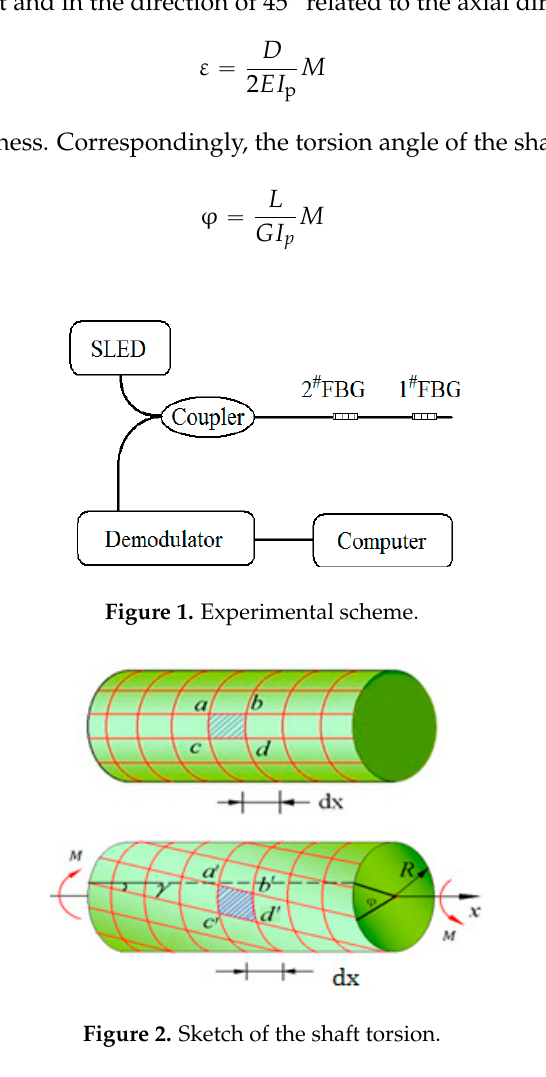
Figure 2. Sketch of the shaft torsion.